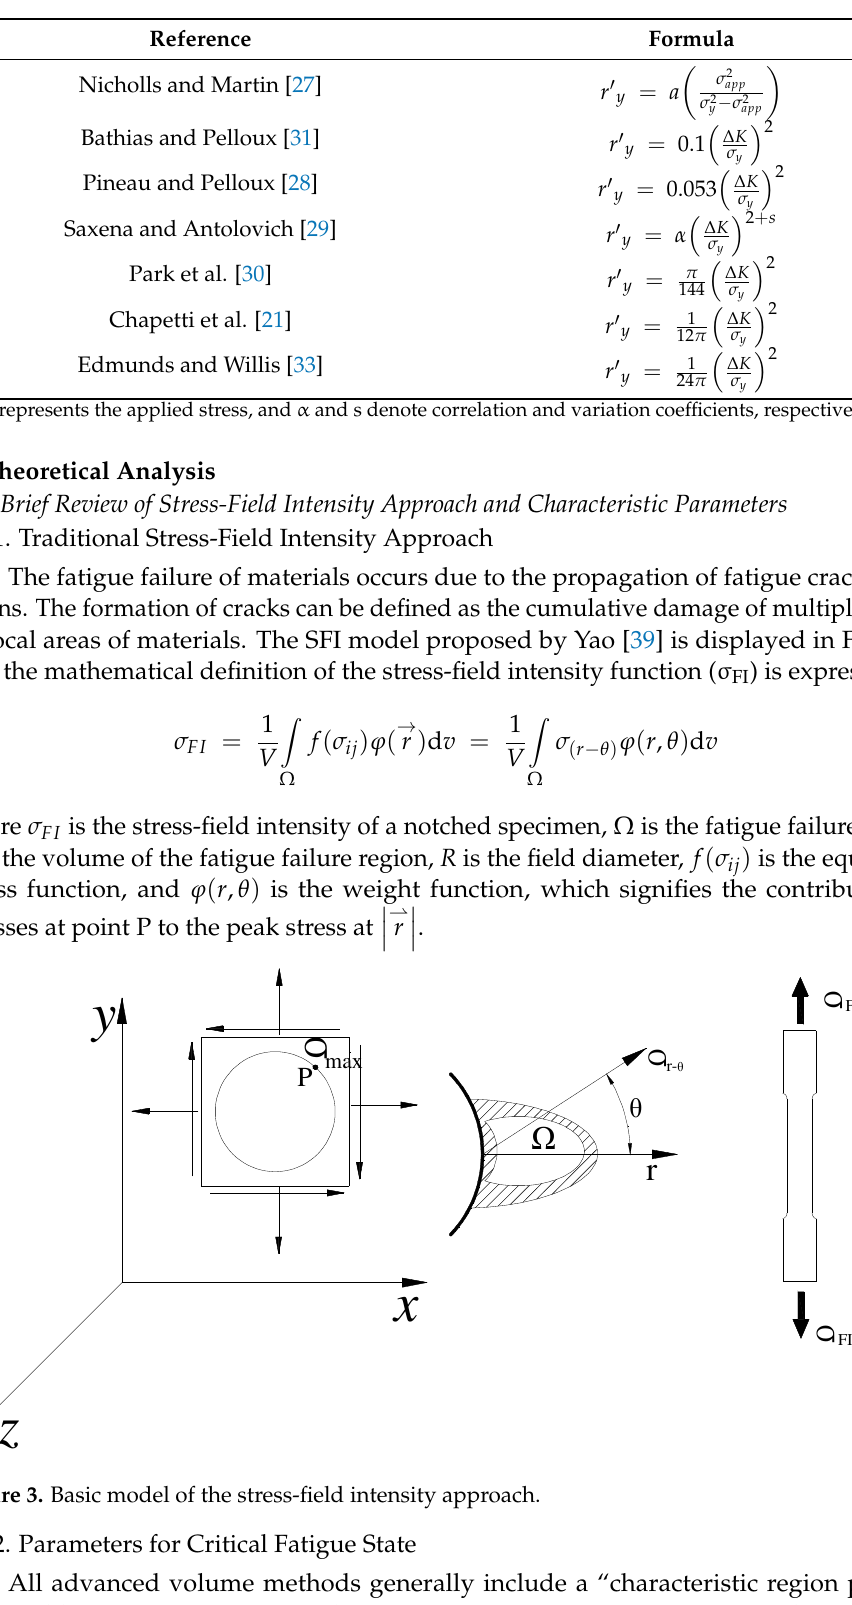
Table 1. Empirical formulas for cyclic plastic zone size calculation.